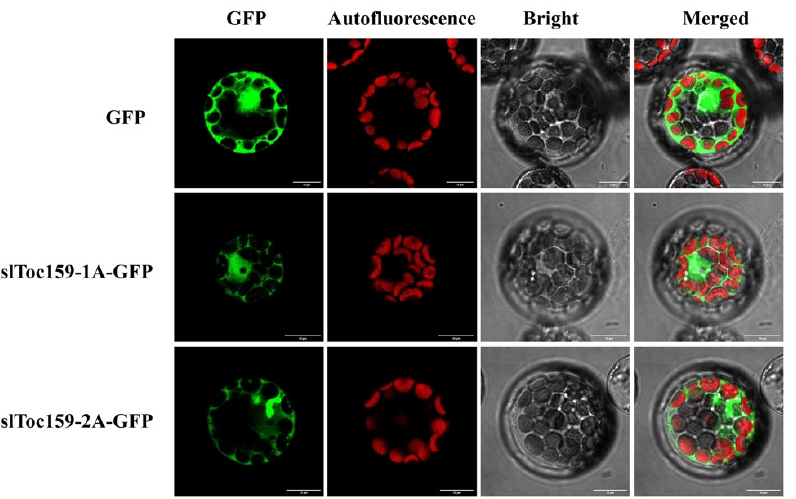
Figure 8. Confocal microscopy images of Arabidopsis thaliana leaf protoplasts transiently expressing slToc159–1A–GFP and slToc159–2A–GFP. The GFP fluorescence signal is shown in green, and chlorophyll autofluorescence is shown in red. Bright-field images confirm the intactness of the protoplasts. An overlay of these three is also shown (Merge). Bars =10 μ m.